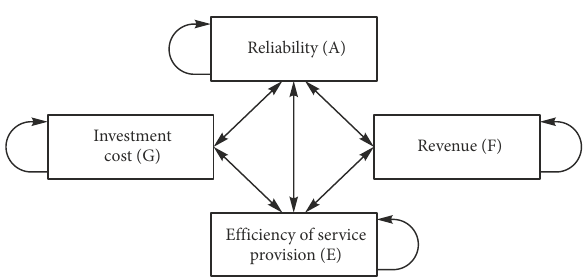
Figure 11. Relationship between dimensions preferred by railway undertakings / railway